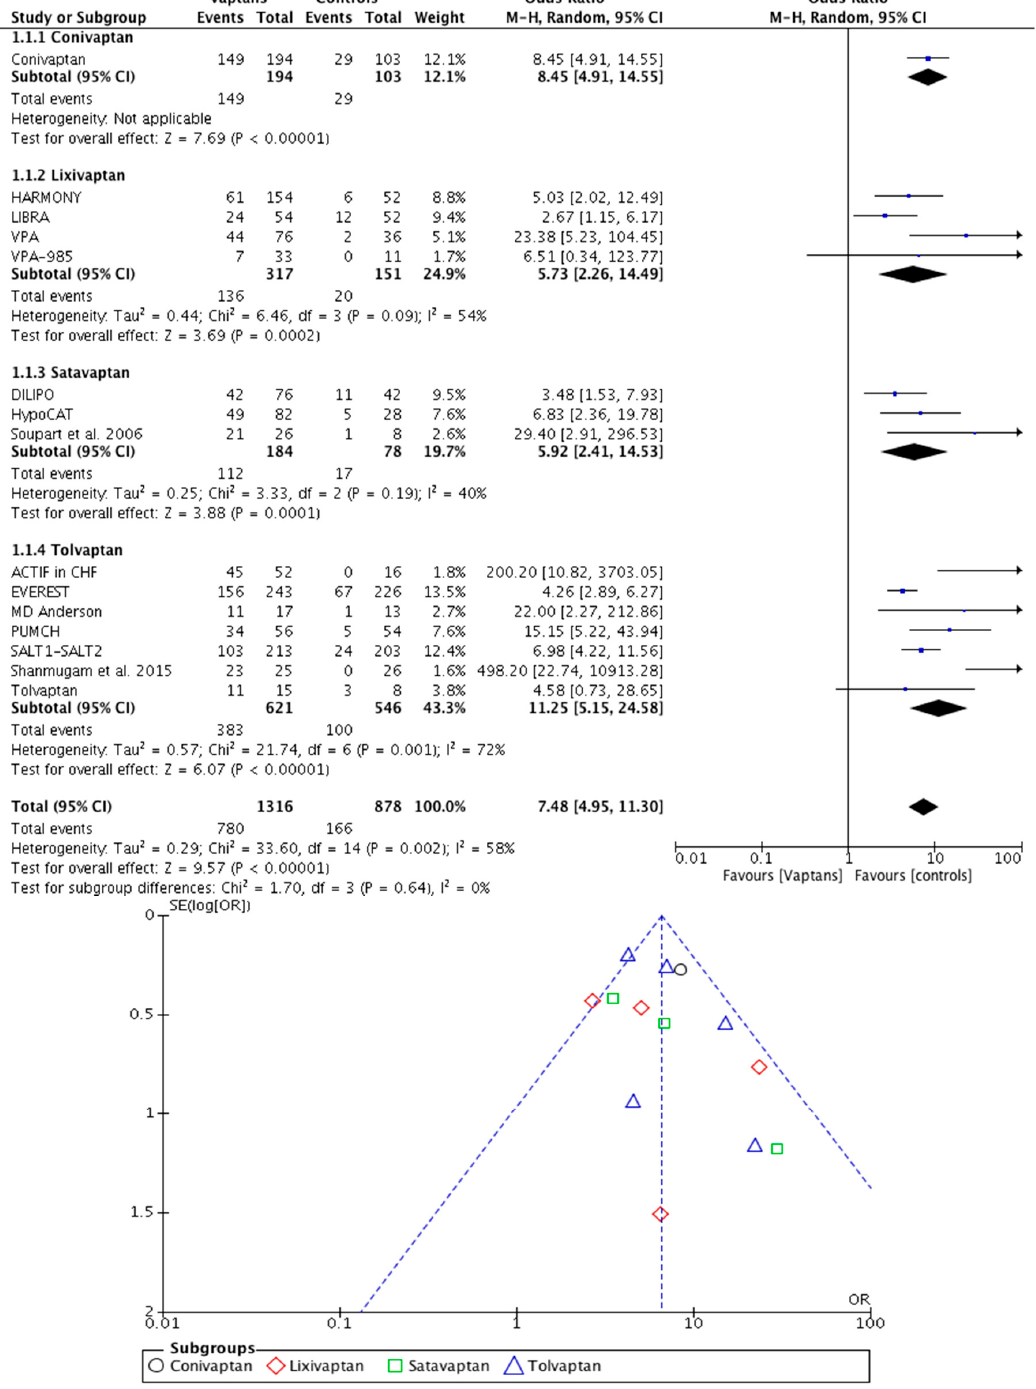
Figure 2. The effect of vaptans on serum sodium concentration. CI, confidence interval; M-H, Mantel–Haenszel test; SE, standard error.